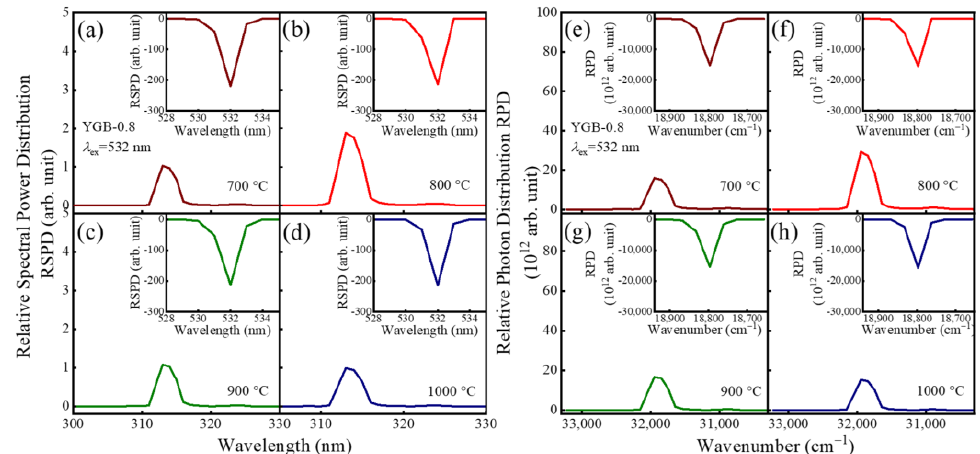
Figure 9. ( a – f ) Relative spectral power distributions and ( e – h ) relative photon distributions of YGB-0.8 samples with different annealing temperatures from 700 °C to 1000 °C under the 532 nm excita- tion.